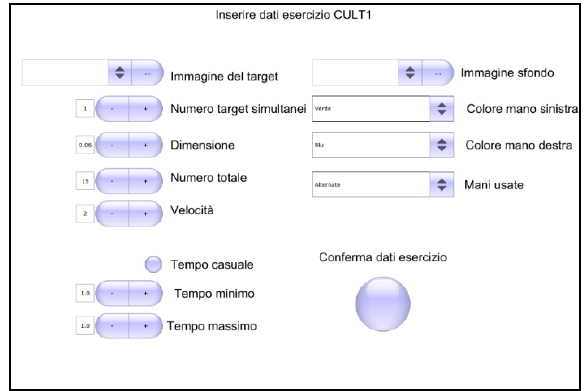
Figure 8. Another screenshot of the game configuration tool. It shows the second page in which therapists can tune the parameters of a specific